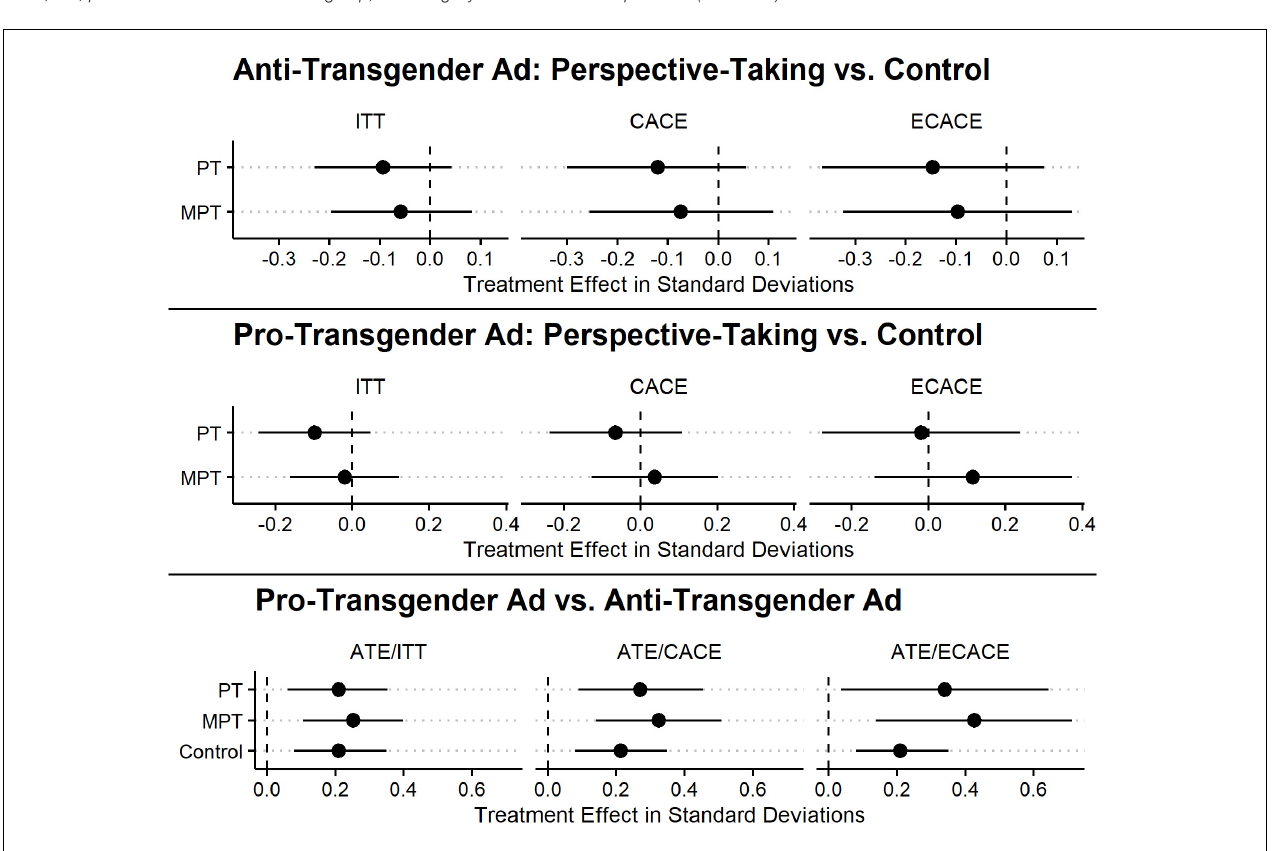
FIGURE 2 | Treatment effect on attitudes toward transgender rights scale, Study 2. 90% confidence intervals represented by error